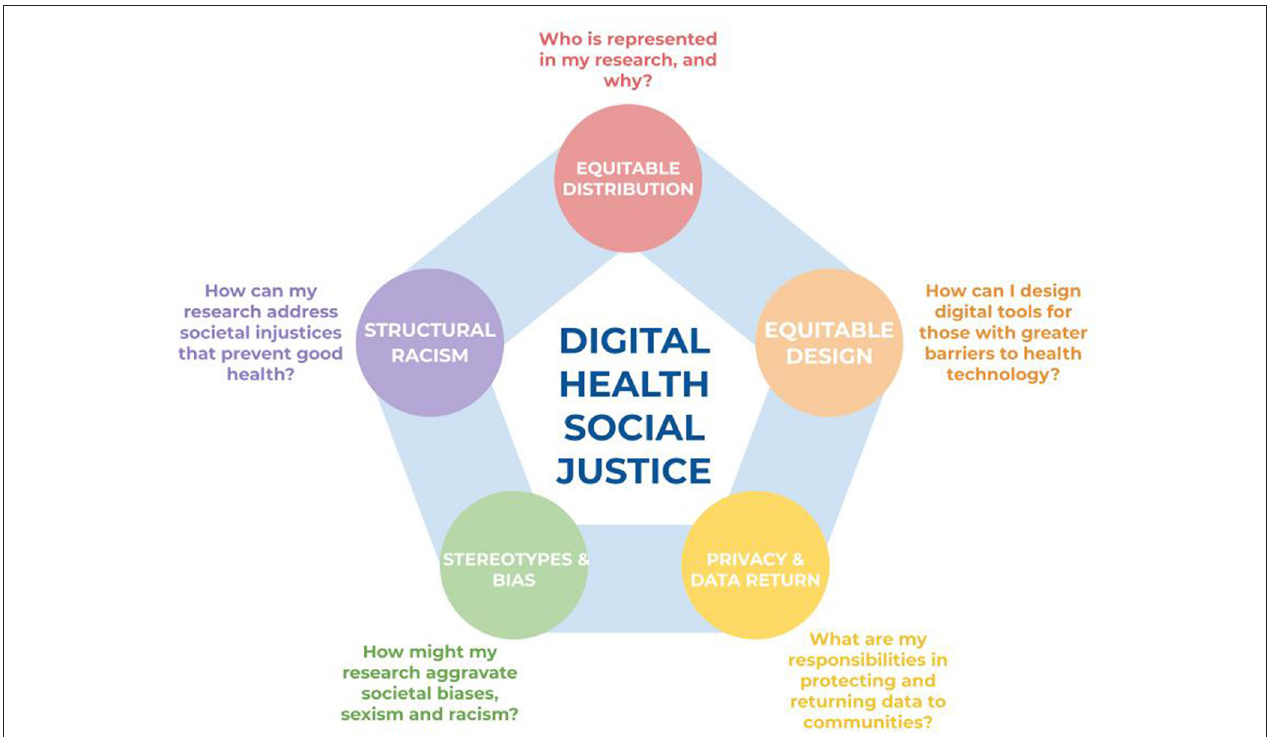
FIGURE 1 | The five key topics and broad questions to guide digital health researchers toward digital health social